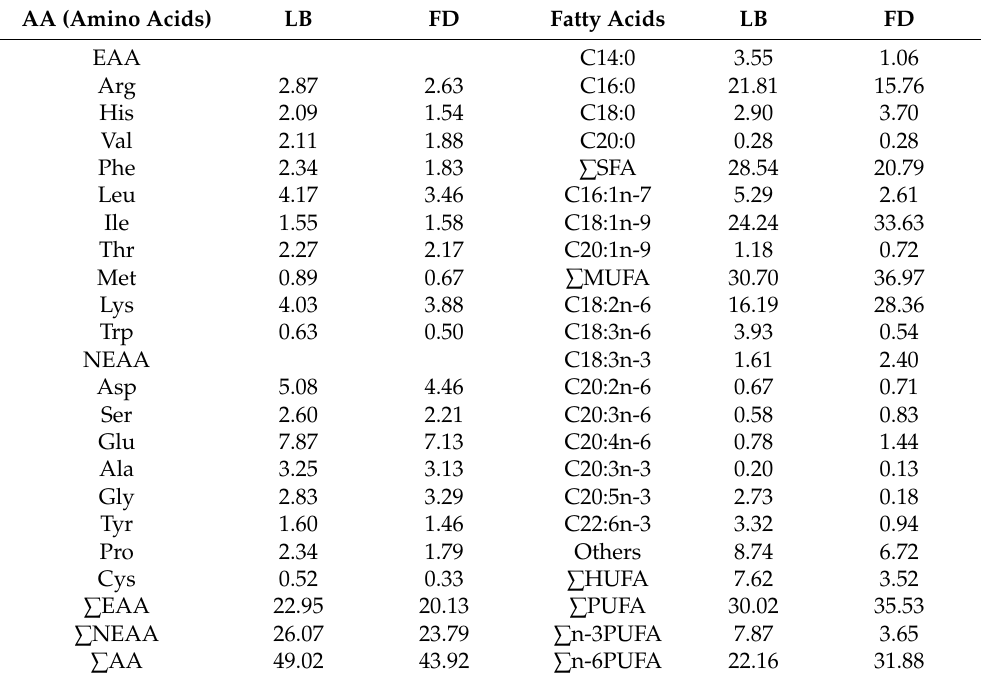
Different letters in the same column indicate significant differences among groups ( p < 0.05). Table 2. The amino acids (g/100 g, dry) and fatty acid (% total fatty acids) composition of live baits and formulated